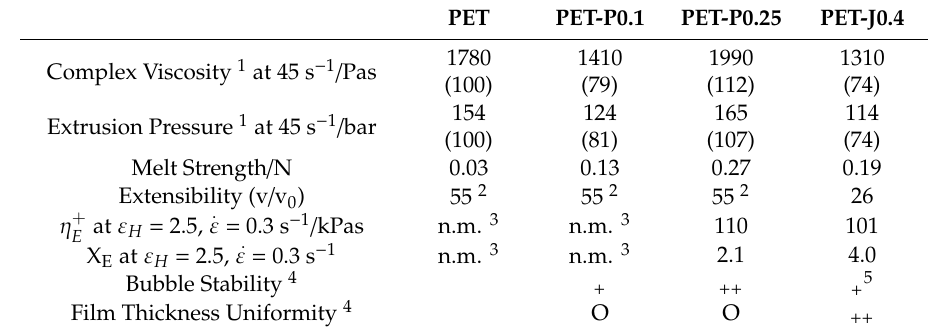
Table 1. Summary of the rheological properties and correlation with characteristic film blowing parameters. The applied temperatures are listed in the Experimental